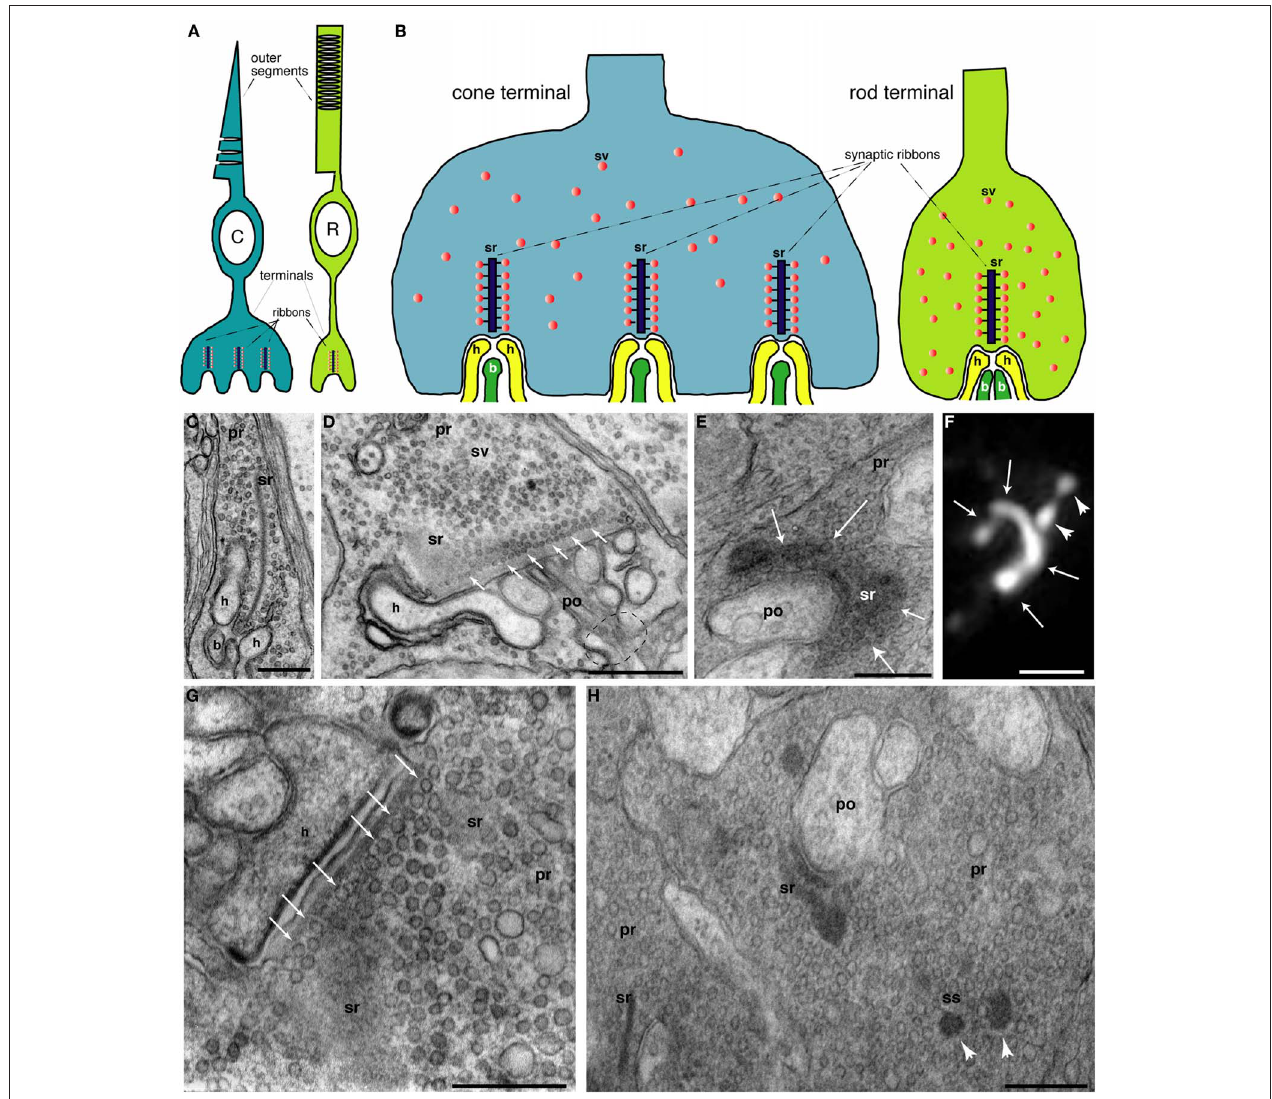
FIGURE 1 | (A) Schematic, simplified drawing of rod (R) and cone (C) photoreceptors. Outer segments (OS) in which phototransduction occurs are depicted as well as the presynaptic terminal where light information is passed from photoreceptors to the secondary neurons, bipolar, and horizontal cells (depicted in yellow and dark green colors in Figure 1B ). Subcellular details of photoreceptors including the inner segments were omitted for sake of clarity. (B) Schematic, simplified drawing of rod and cone photoreceptor presynaptic terminals. Rod synapses possess only a single, large active zone with a single synaptic ribbon (sr) whereas cones possess multiple active zones (20–50). Only invaginating ribbon synapses are depicted. Non-invaginating, non-ribbon type synapses (Regus-Leidig and Brandstätter, 2011) are not shown. (C–E, G–H) Electron micrographs of photoreceptor terminals. (C) Shows a cross-sectioned ribbon (sr) with its typical bar-shaped appearance in a rod terminal. The synaptic ribbon is associated with large numbers of synaptic vesicles (sv) (D) . The rod photoreceptor in (D) is largely sectioned parallel to the plate-like synaptic ribbon. In the left part, the section passes through the synaptic ribbon (sr); more to the right, the plane of section is parallel, but close to the plate-like synaptic ribbon. Many docked synaptic vesicles can be observed at the base of the synaptic ribbon (small white arrows). The dashed circle indicates the site where the postsynaptic dendrites enter the postsynaptic cavity formed